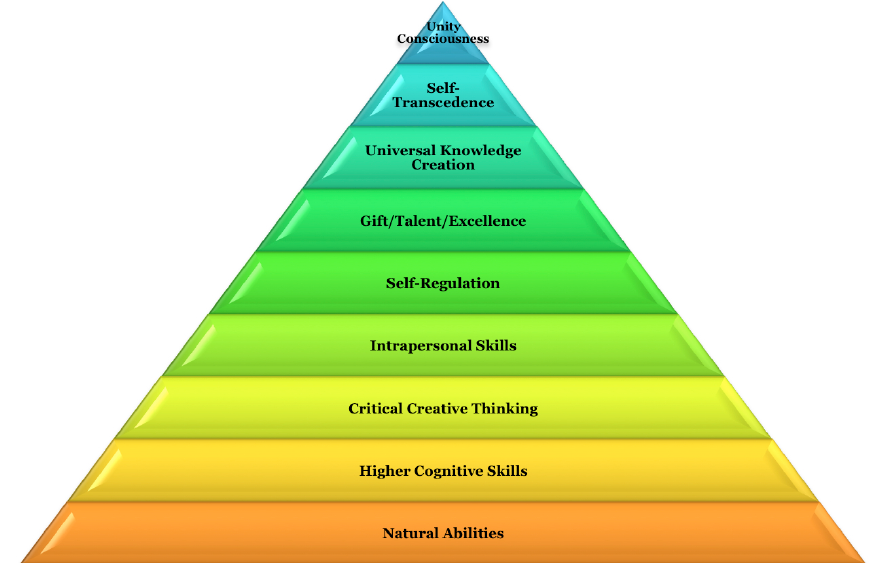
Fig. 1. The 9-layer pyramid : Natural abilities (intellectual-socioaffective-sensorimotor)